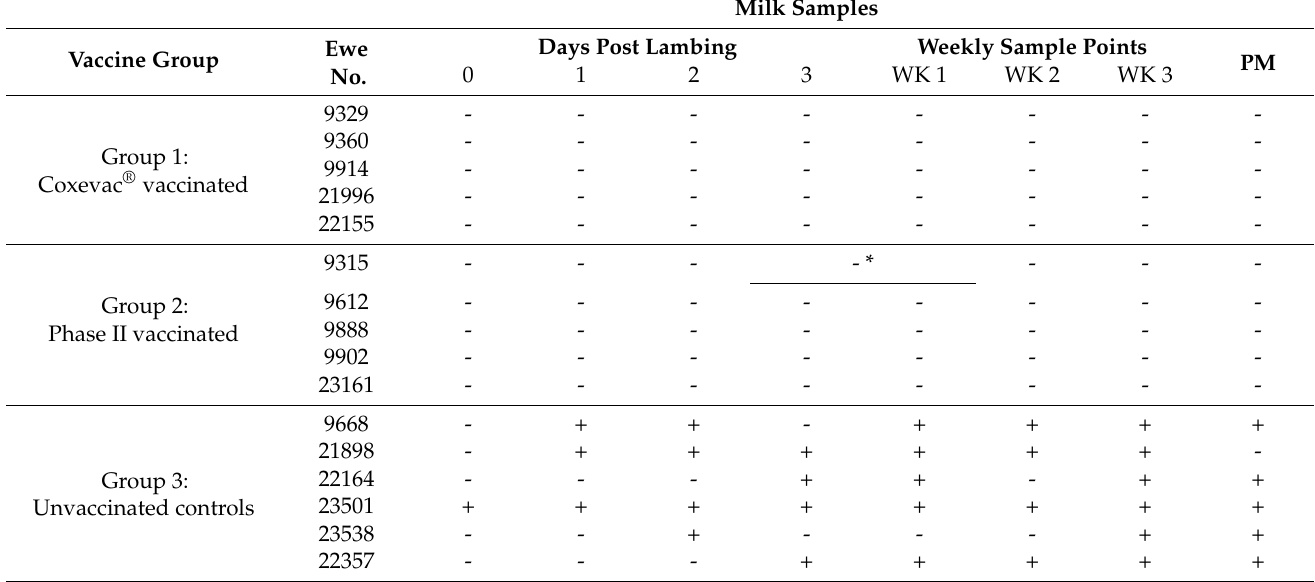
Table 2. Presence (+) or absence (-) of C. burnetii DNA in milk samples. Samples were collected on day of lambing (0) and then for three consecutive days (1, 2 and 3). Samples were then collected weekly for 3 weeks, with a final sample set collected immediately prior to post-mortem (PM).